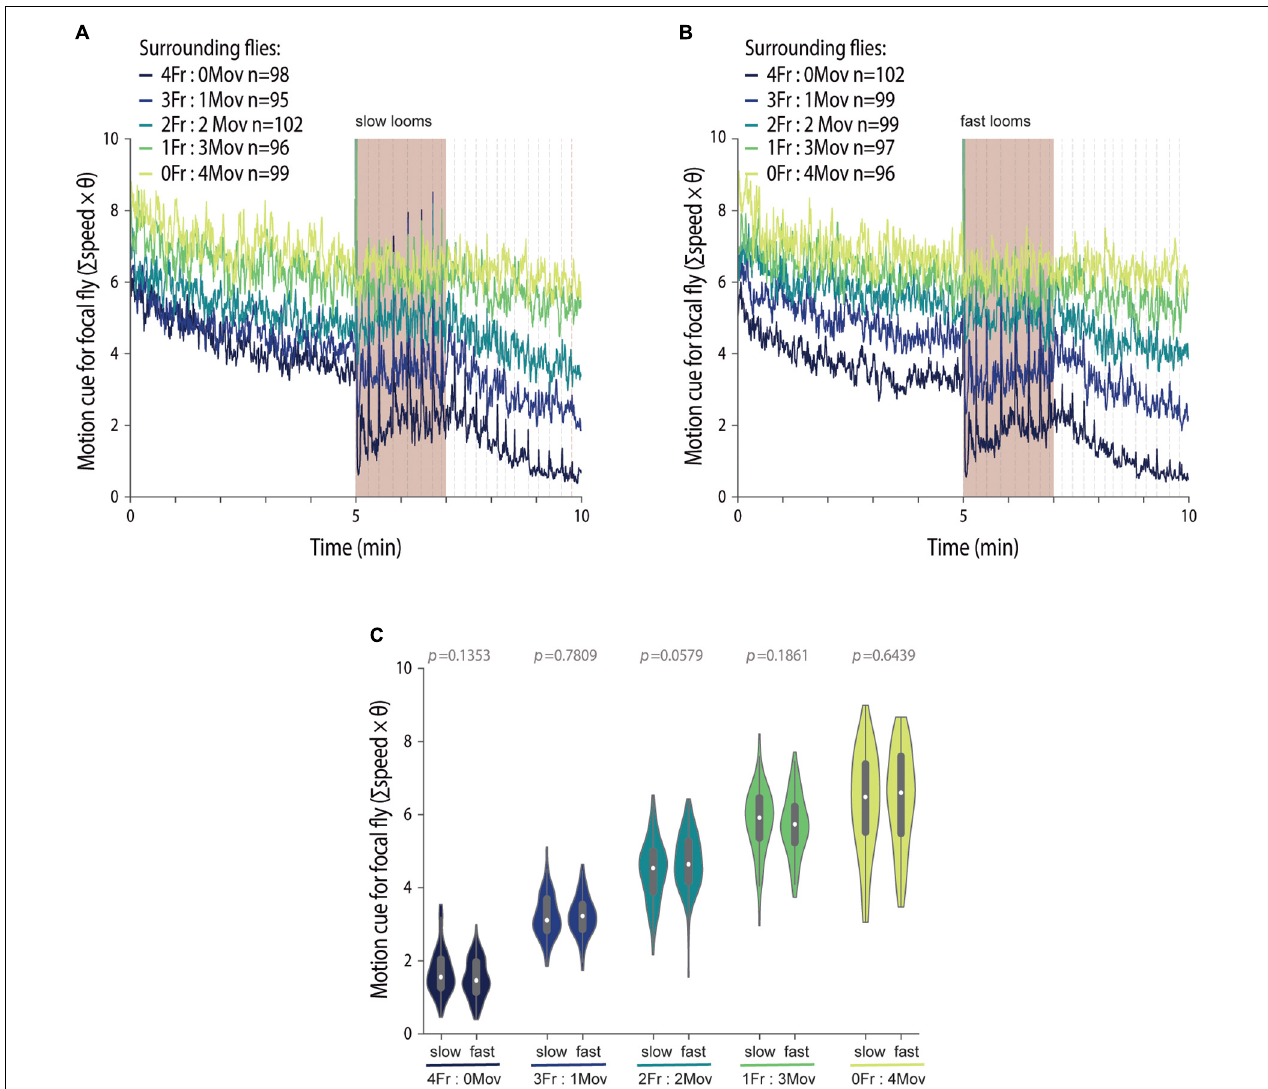
FIGURE 3 | Manipulating the social environment produces similar motion cues across threat imminences. (A–C) We manipulated four out of the five flies in a group, to surround focal flies with groups with different proportions of flies that always move (blind flies, NorpA) and flies that are optogenetically made to freeze (LC6 > CsChrimson). The color code for the groups is presented in (A,B) . Motion cues (refer to the section “Materials and Methods”) produced by the manipulated surrounding flies throughout the experiment when exposed to slow (A) or fast looming stimuli (B) ; dashed lines represent looming stimuli presentations; n represents the numbers of groups tested for each condition. (C) Violin plot representing the probability density distribution of individual fly data bound to the range of possible values, with boxplots elements: [central white dot, median; box limits, upper (75) and lower (25) quartiles; whiskers, 1.5 × interquartile range]. Average motion cues produced by the manipulated surrounding flies during the stimulation period. P -values result from the two-tailed Mann–Whitney test; significance is determined via Bonferroni